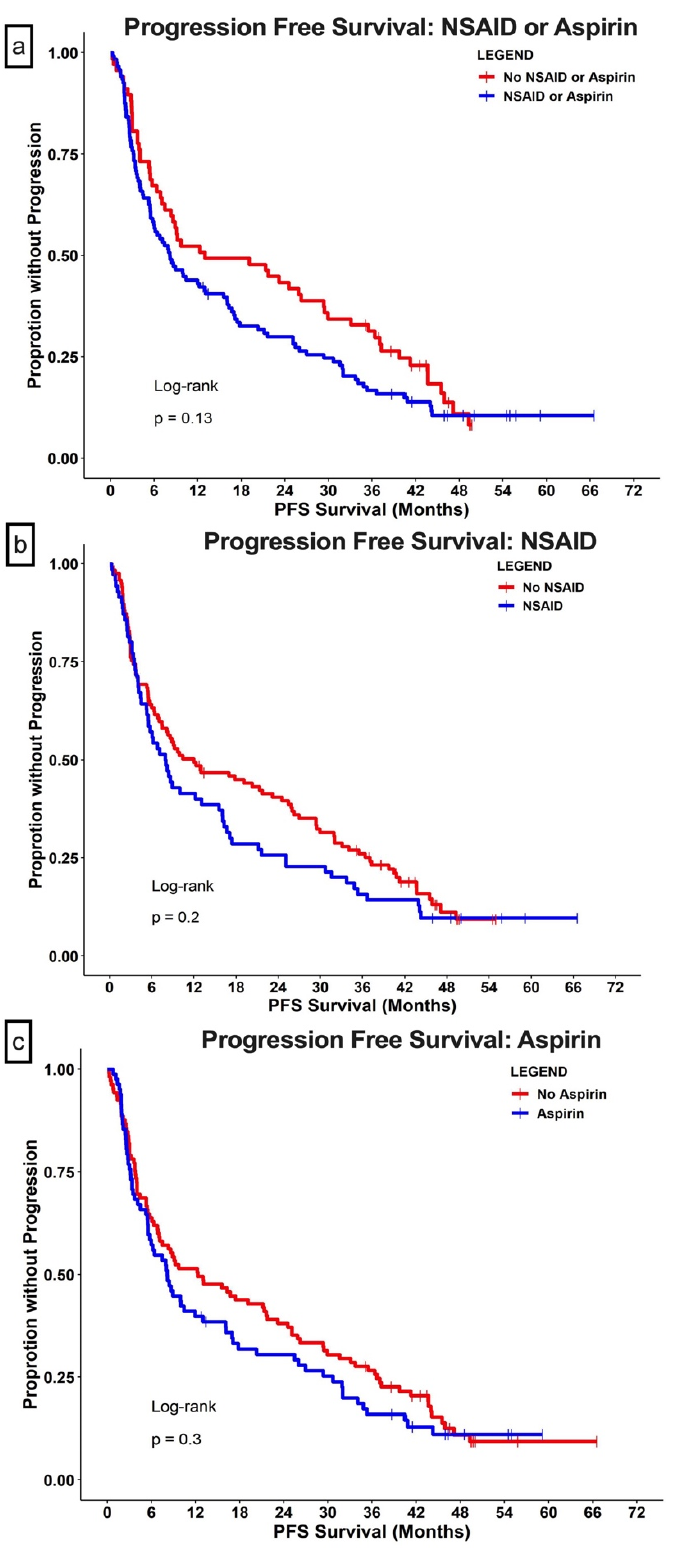
Figure 3. Progression-free survival (PFS). Patients with metastatic renal cell carcinoma were grouped based on concurrent use of ( a ) COX inhibitors (aspirin or NSAID); ( b ) use of aspirin; or ( c ) use of NSAID. The dots in all panels indicate censored data.